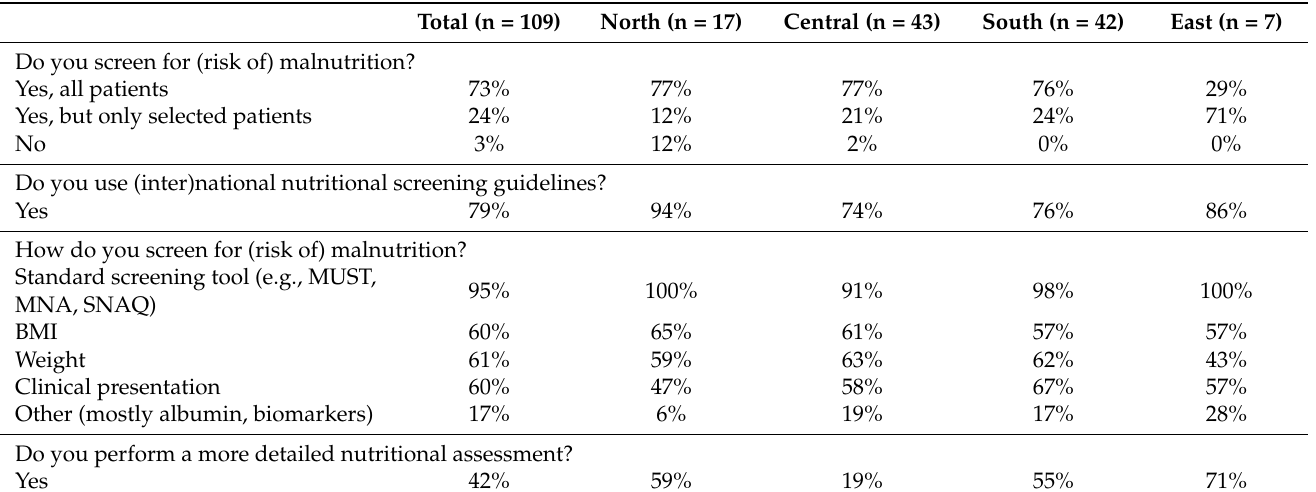
Table 3. Screening for (risk of)